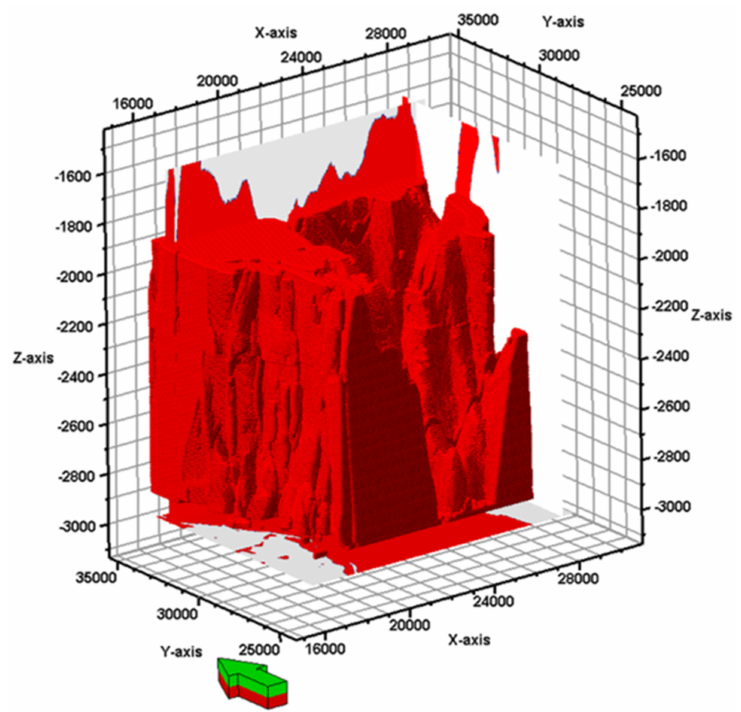
Figure 18. The predicted result of a salt body in 3D cube visualization.